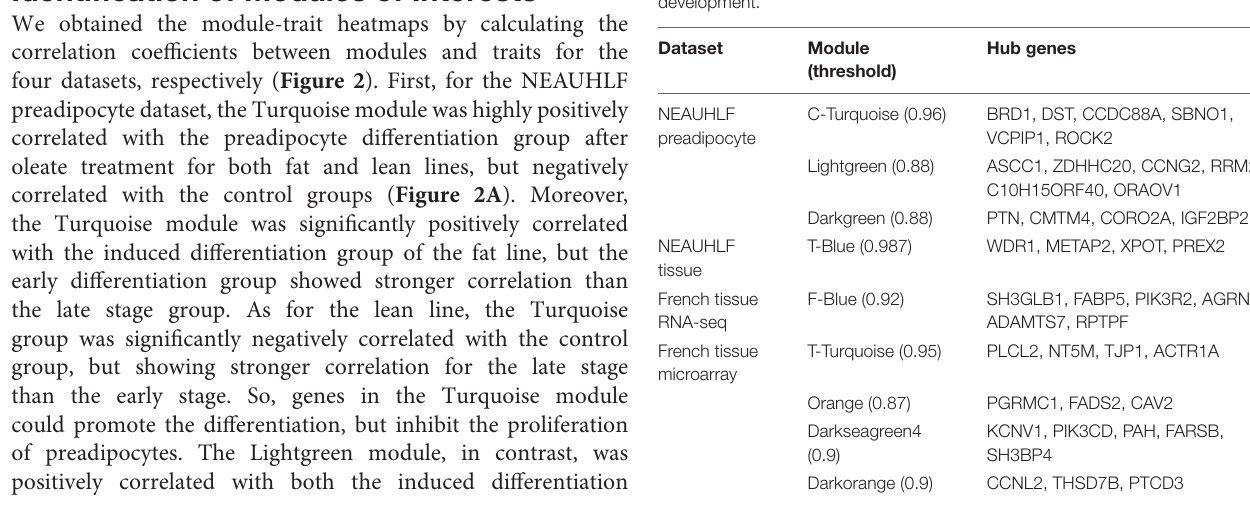
genes were Turquoise (1,173) and Darkgray (42) ( Figure 1A ), Blue (3,457) and Purple (163) ( Figure 1B ), Turquoise (1,173) and Tan (33) ( Figure 1C ), Lightgreen (838) and Mediumorchid (31) ( Figure 1D ), respectively.